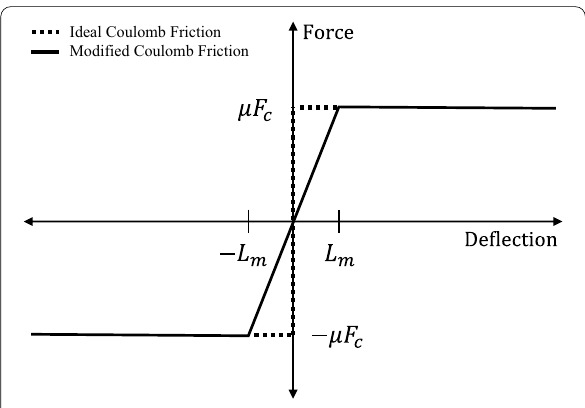
Fig. 2 Coulomb friction model used in